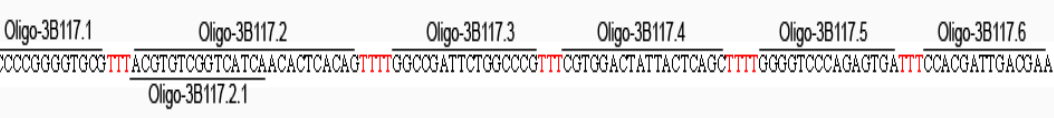
Figure 1. The nucleotide sequence of 3B117. The six segments that were used to design oligonucleotide probes were indicated.